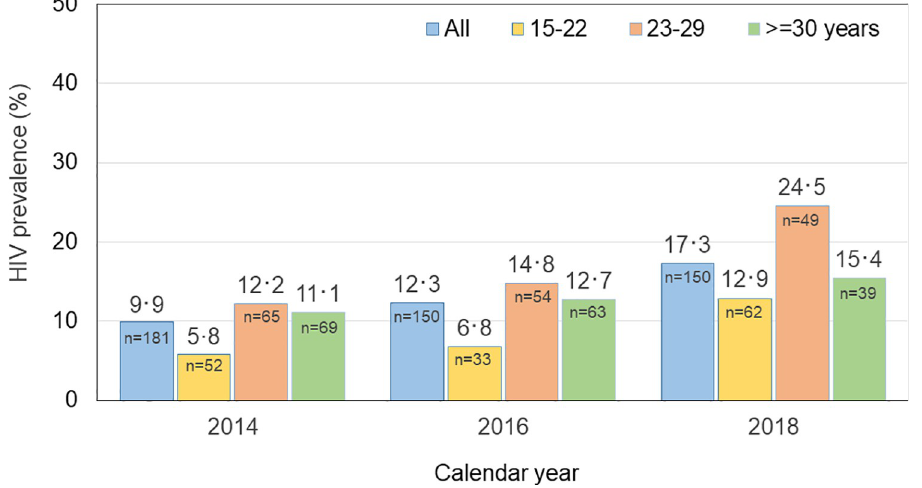
Fig 4. HIV prevalence among transgender women, integrated behavioral and biological surveillance, Bangkok, 2014–2018, by age